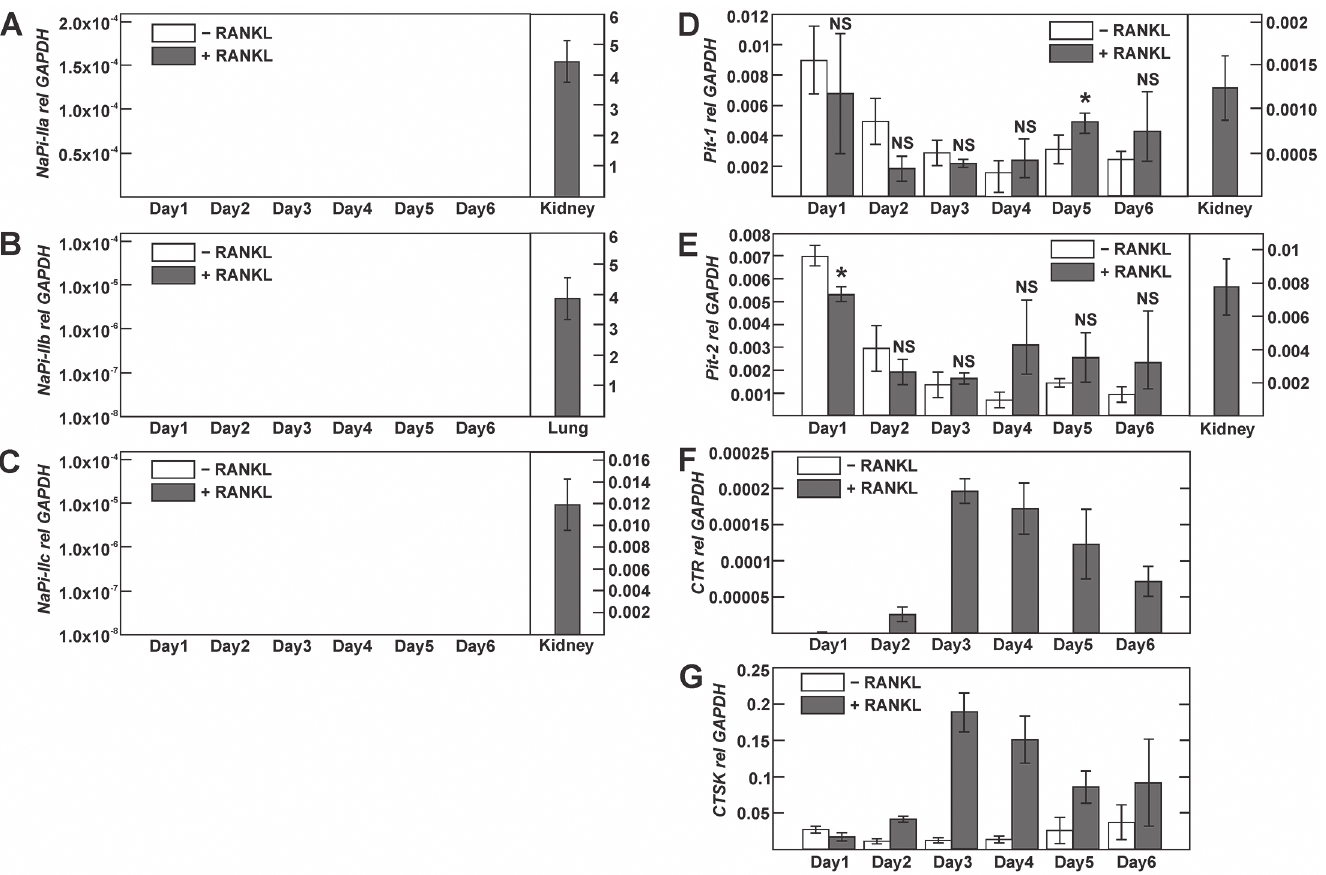
Fig 3. Expression of type II and III phosphate transporter isoforms during osteoclast differentiation of RAW 264.7 cells. RAW 264.7 cells were cultured with or without RANKL for 6 days. A-E) NaPi transcript expression was assessed by real-time PCR analysis. F, G) Calcitonin receptor (CTR) and cathepsin K (CTSK) were used as markers of osteoclast differentiation. No signal was detected for NaPi-IIa, NaPi-IIb and NaPi-IIc at any time point irrespective of the presence or absence of RANKL (not shown). Positive control PCRs in A-E were done with kidney cDNA for NaPi-IIa, NaPi-IIc, Pit-1 and Pit-2 and lung cDNA for NaPi-IIb. The amount of mRNA relative to GAPDH was calculated using the Δ Ct method. Values are shown as means ± SD; n = 3 independent experiments/group. * p < 0.05; NS, not significant.